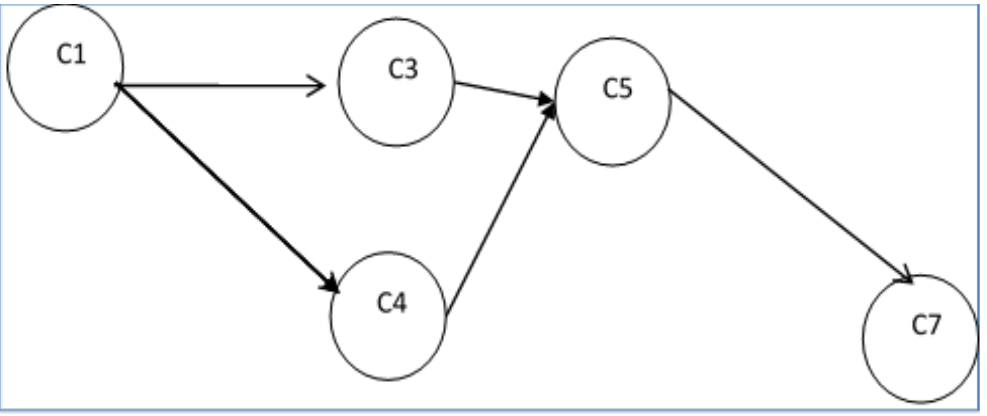
Fig. 2. Prime vertex with